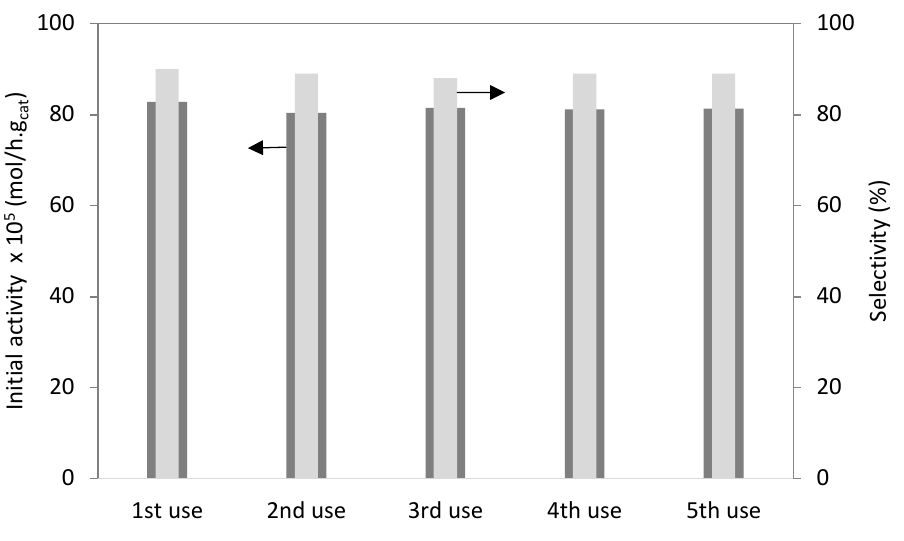
Figure 12. Hydration of camphene over PW4‑SBA‑15‑SO 3 H. Catalytic stability (initial activity) and isoborneol selectivity (%) after 70 h.